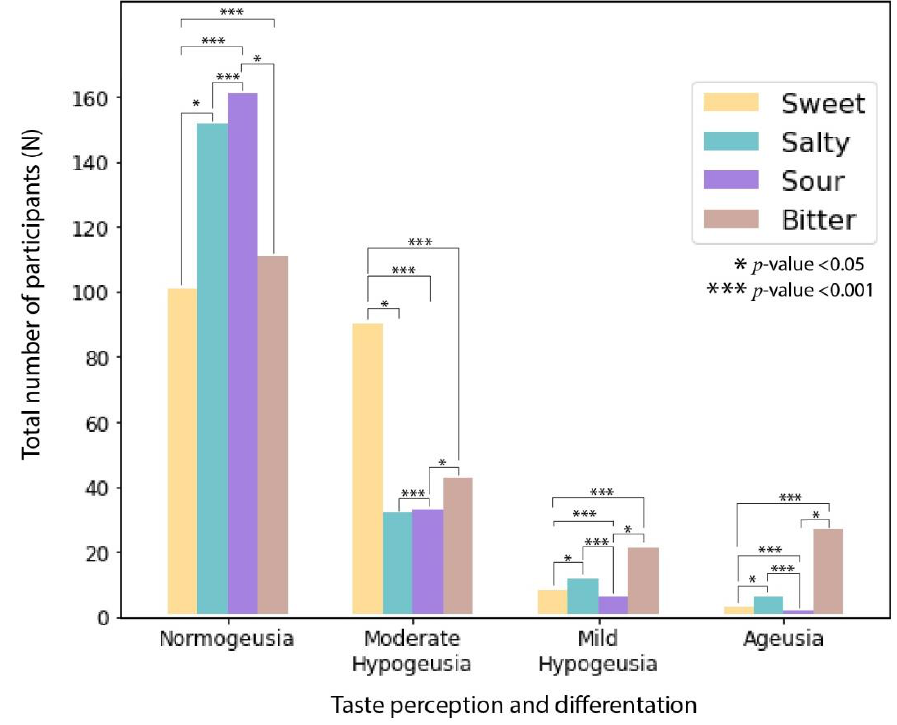
Figure 7. The gustatory perception and differentiation ability for different